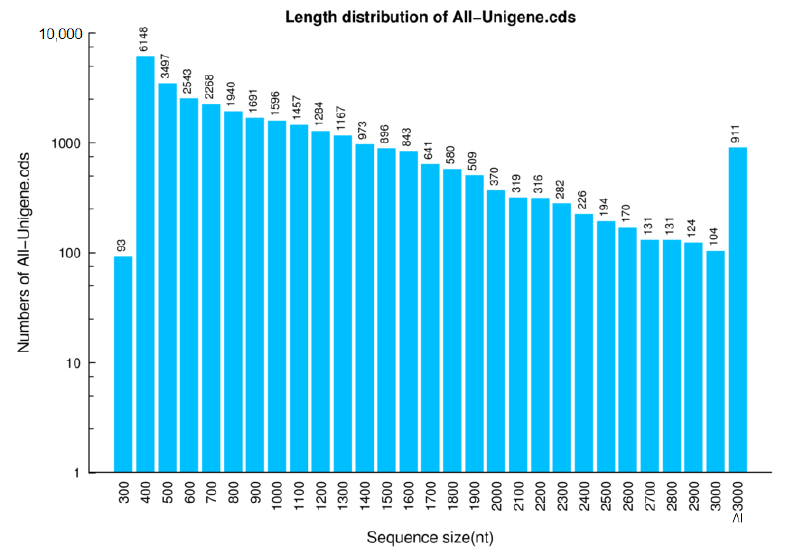
Figure 1. Length distribution of the unigene coding sequences generated from Transdecoder. As for species distribution, 36.9% of the 96,712 unigenes have high similarity to genes from Asparagus officinalis , followed by Elaeis guineensis (7.6%), Phoenix dactylifera (5.12%), and Ananas comosus (2.95%) (Figure